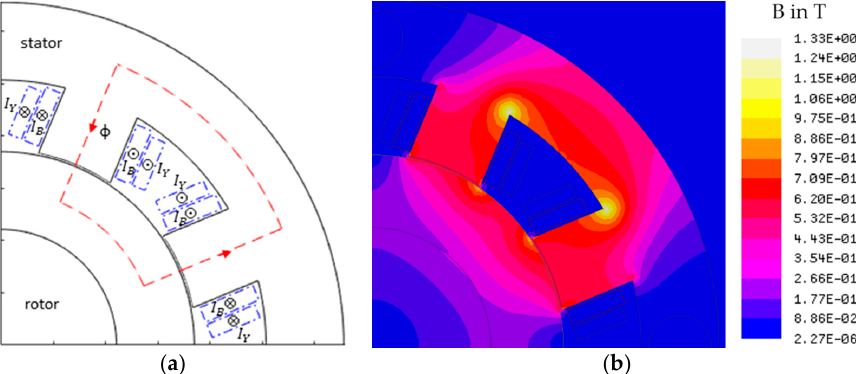
Figure 5. ( a ) Quarter of the cross section of the upper radial active magnetic bearings (AMB); ( b ) Magnetic flux density in the upper radial AMB with only the bias current as excitation. The rotor turns clockwise.